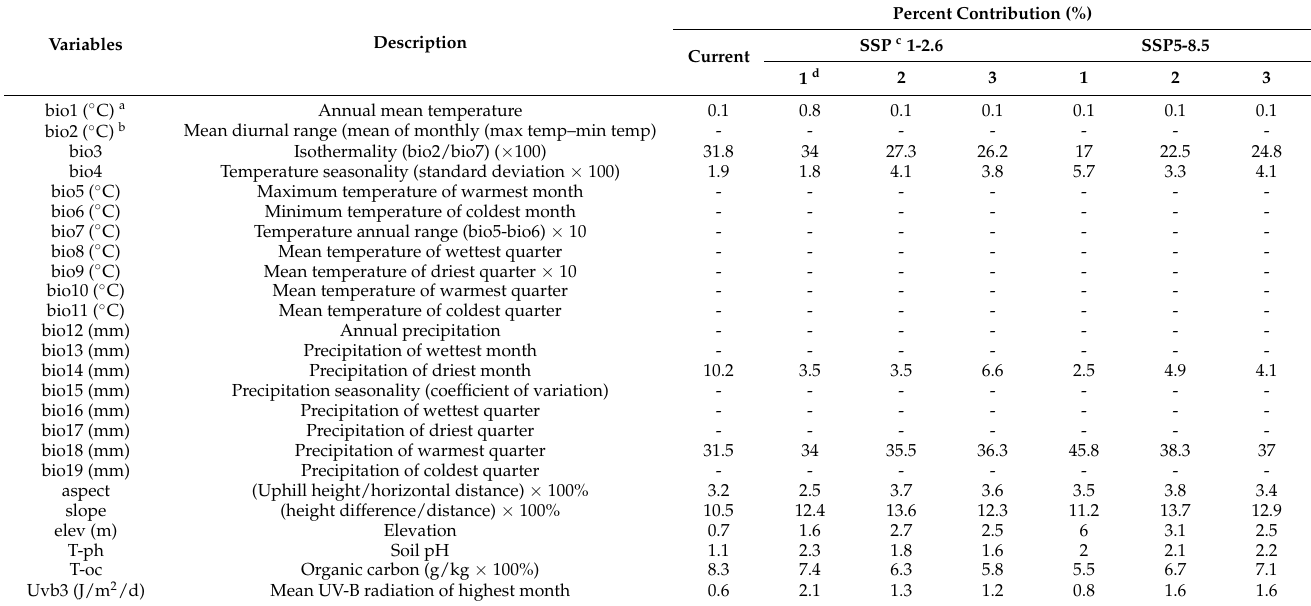
Table 1. The environmental factors used in the model and their contributions in predicting the current and future distributions of Ferrocalamus strictus in